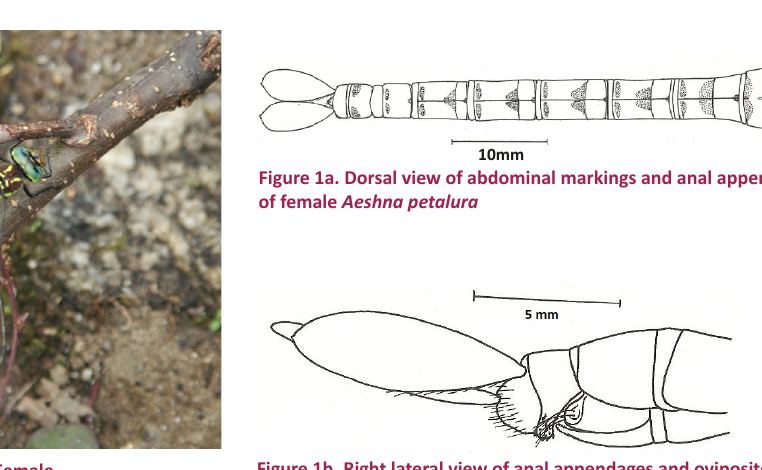
Figure 1b. Right lateral view of anal appendages and ovipositor